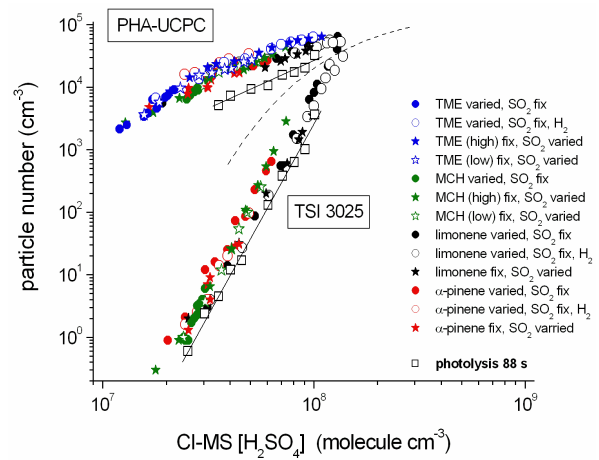
Fig. 3. Measurements of the particle numbers by PHA-UCPC (cor- rected) and TSI 3025 as a function of the H 2 SO 4 concentration. The dashed line separates the data from both particle counters. The reactant concentrations are given in Table 1, measurement series 1–7, 9–11 and 13–15. Measurement data from ozone photolysis ex- periments (full lines) in absence of added organics are shown for